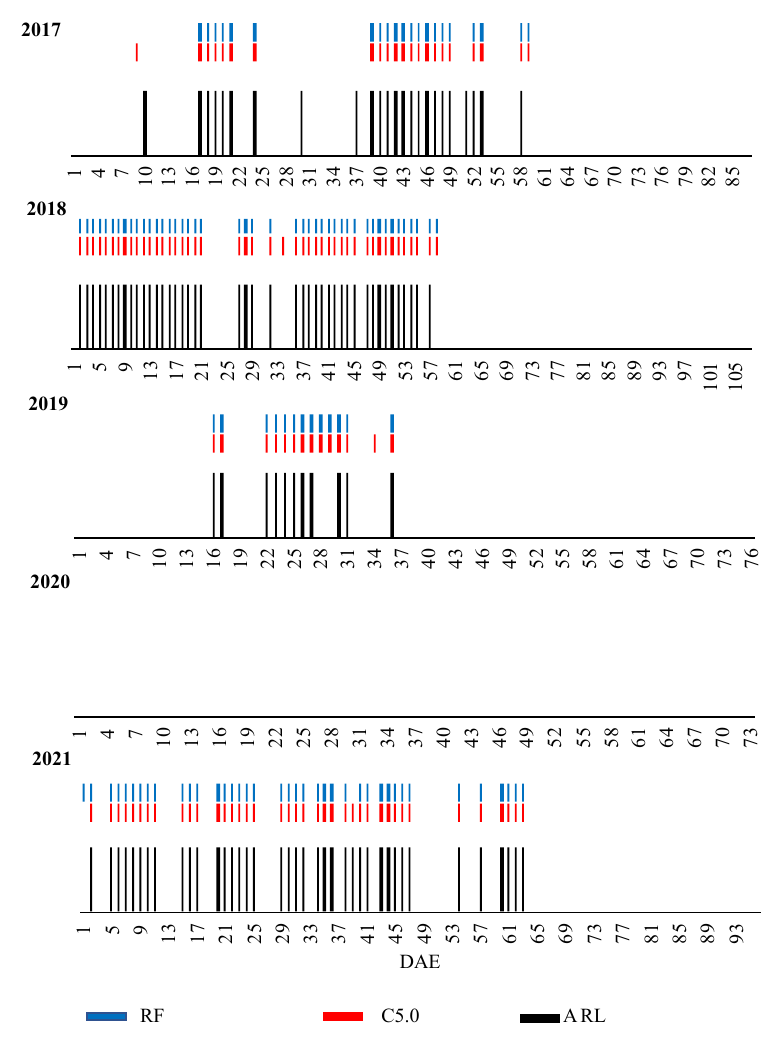
9 of 14 Figure 2. Receiver operating curve (ROC) for comparing the machine learning models random for- est (RF) and C5.0 decision tree (C5.0). The broken lines in the ROC curve represent a classi fi er with no predictive value (diagonal line) and a perfect classi fi er (horizontal and vertical lines). ROC curves that are closer to the perfect classi fi er show a be tt er model. 3.6. Checking Aerobiological Risk Level Prediction by Machine Learning Algorithms The resulting predictions from each model algorithm with the observed SRL (aerobi- ological data) were compared. The prediction result of applying each of the algorithms to the sporangia level from the fi ve growing seasons based on the SRL is shown in Figure 3. Overall, the algorithms made an accurate prediction in all fi ve years of the study, even in the anomalous year of 2020. In this year, no day with a daily concentration of more than